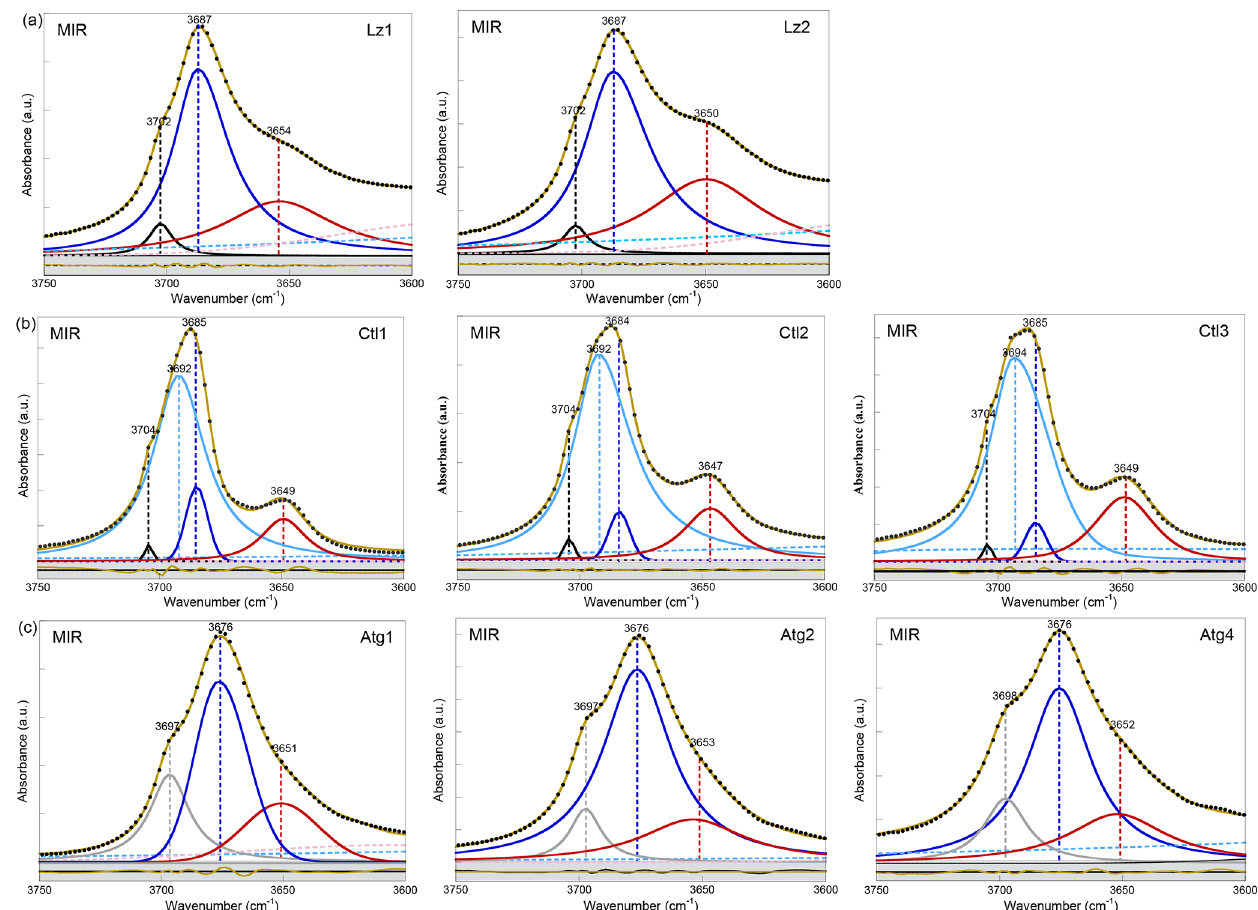
Figure A2. MIR spectra in the 3750–3600cm − 1 range (first overtone region of OH stretching bands) of (a) lizardite (Lz1, Lz2), (b) chrysotile (Ctl1, Ctl2, Ctl3), and (c) antigorite (Atg1, Atg2, Atg4). The spectra have been decomposed into individual components using asymmetric Lorentzian–Gaussian functions. Black dots: experimental data. Solid brown line: best fit (residues in bottom grey box). Plain black and grey curves: inner OH stretching modes. Plain blue and red (or purple) curves: interlayer OH stretching modes. Dashed pink and light blue curves: H 2 O vibration